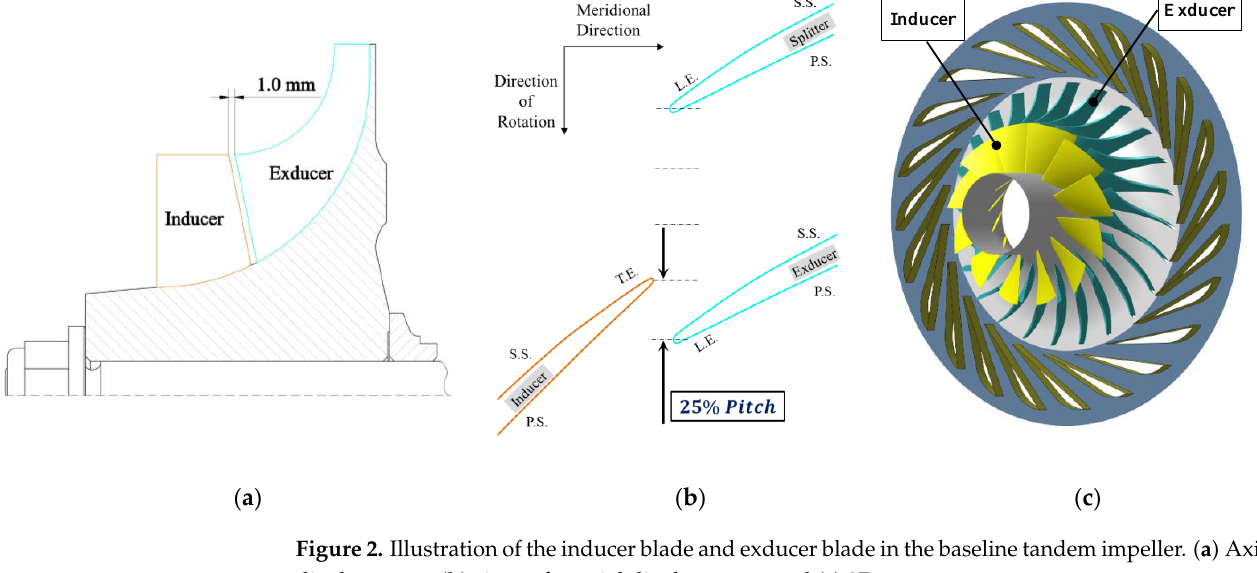
Figure 2. Illustration of the inducer blade and exducer blade in the baseline tandem impeller. ( a ) Axial displacement, ( b ) circumferential displacement, and ( c ) 3D geometry.